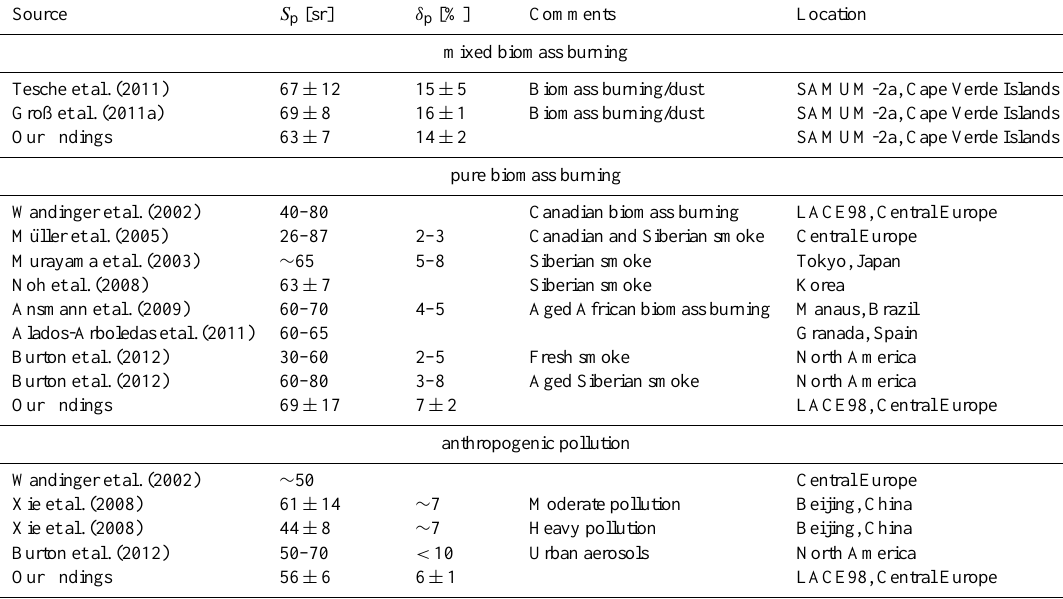
Table 6. Summary of the key findings concerning the lidar ratio ( S p ) and the particle linear depolarization ratio ( δ p ) found in mixed and pure biomass burning aerosol plumes and for anthropogenic pollution.